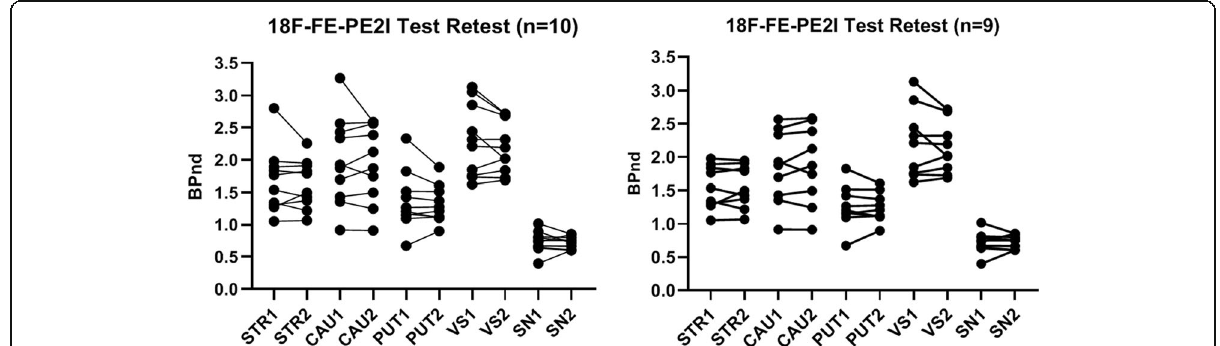
Fig. 2 Individual BP ND values between scan 1 and scan 2. Striatal regions and substantia nigra, with and without the exclusion of the outlier, are displayed